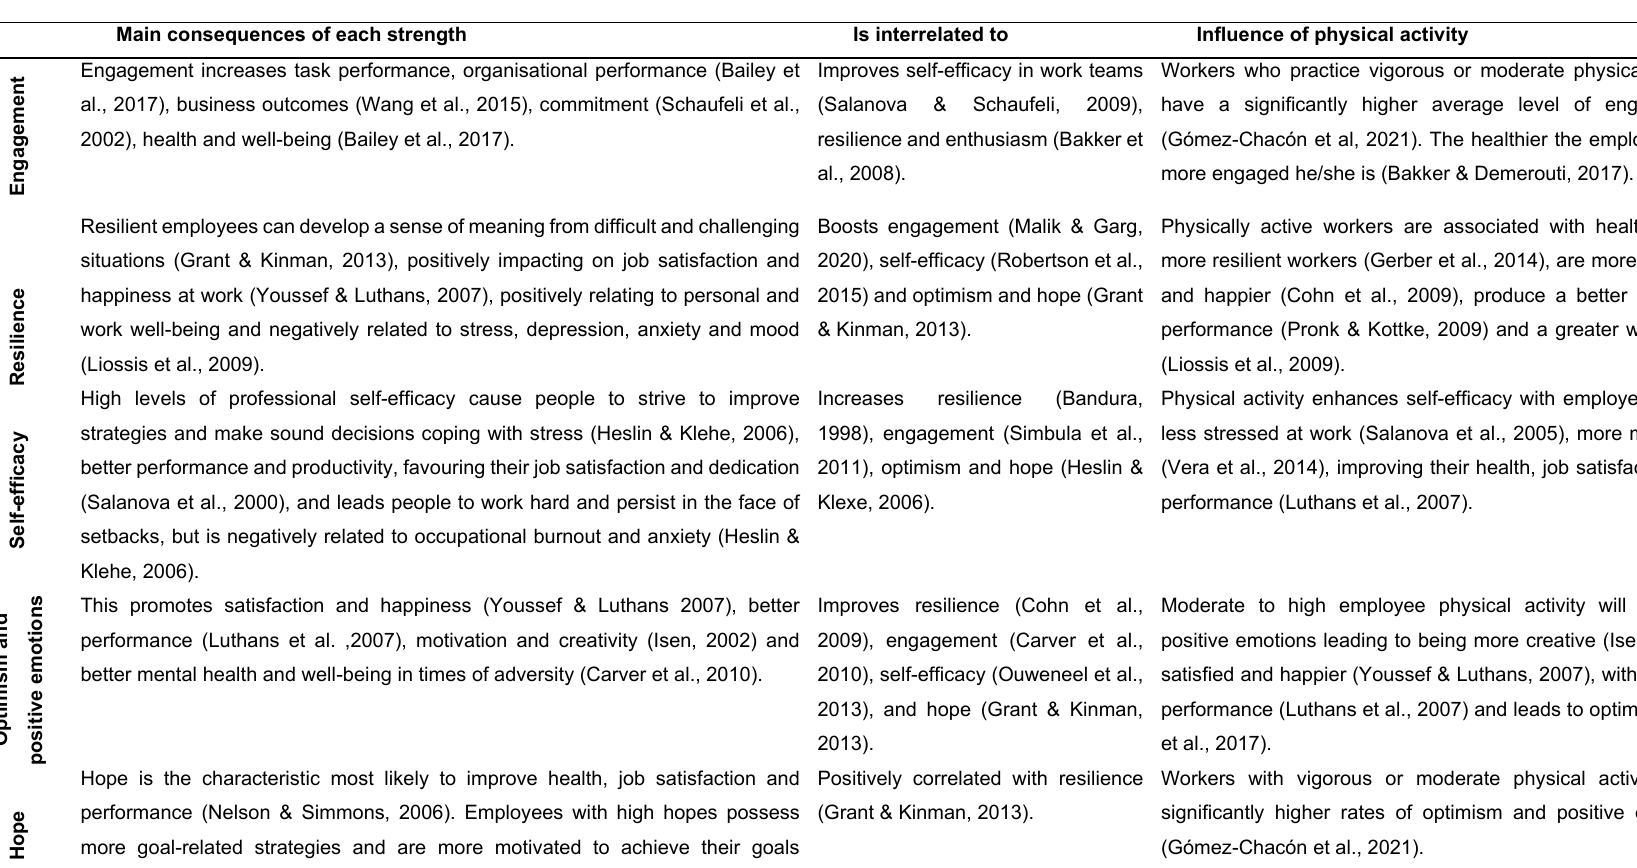
Table 1. Strengths of the healthy employee and their consequences for the organisation, the interrelationships between these strengths and the influence of physical activity on these strengths.